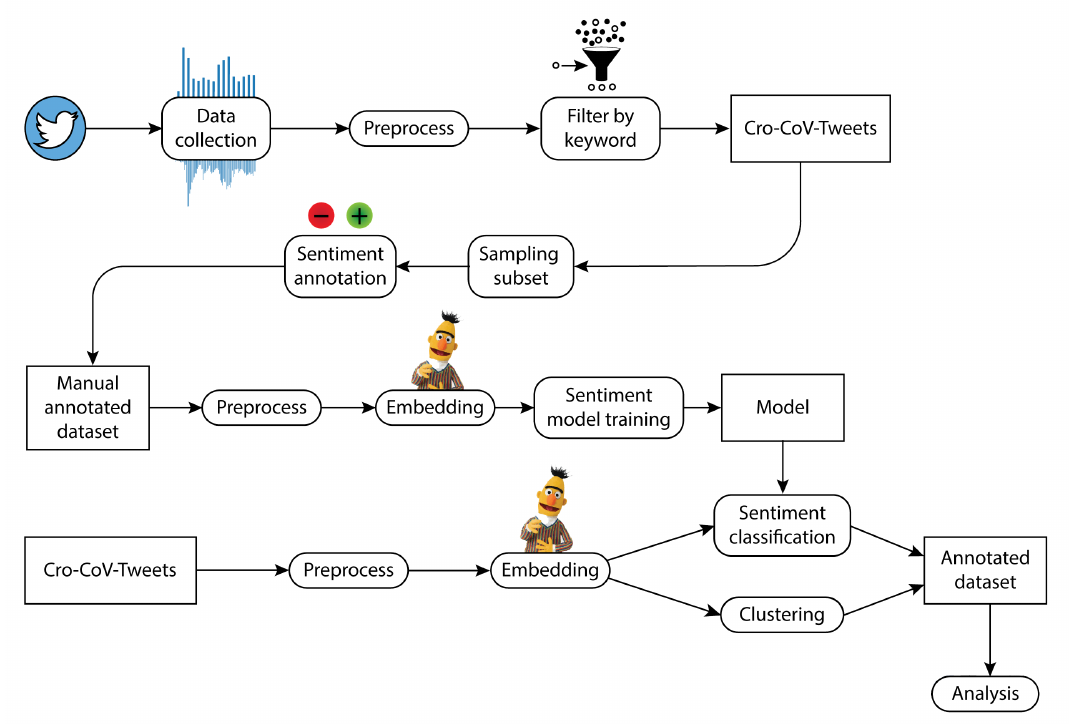
Figure 2. The sequential workflow of the